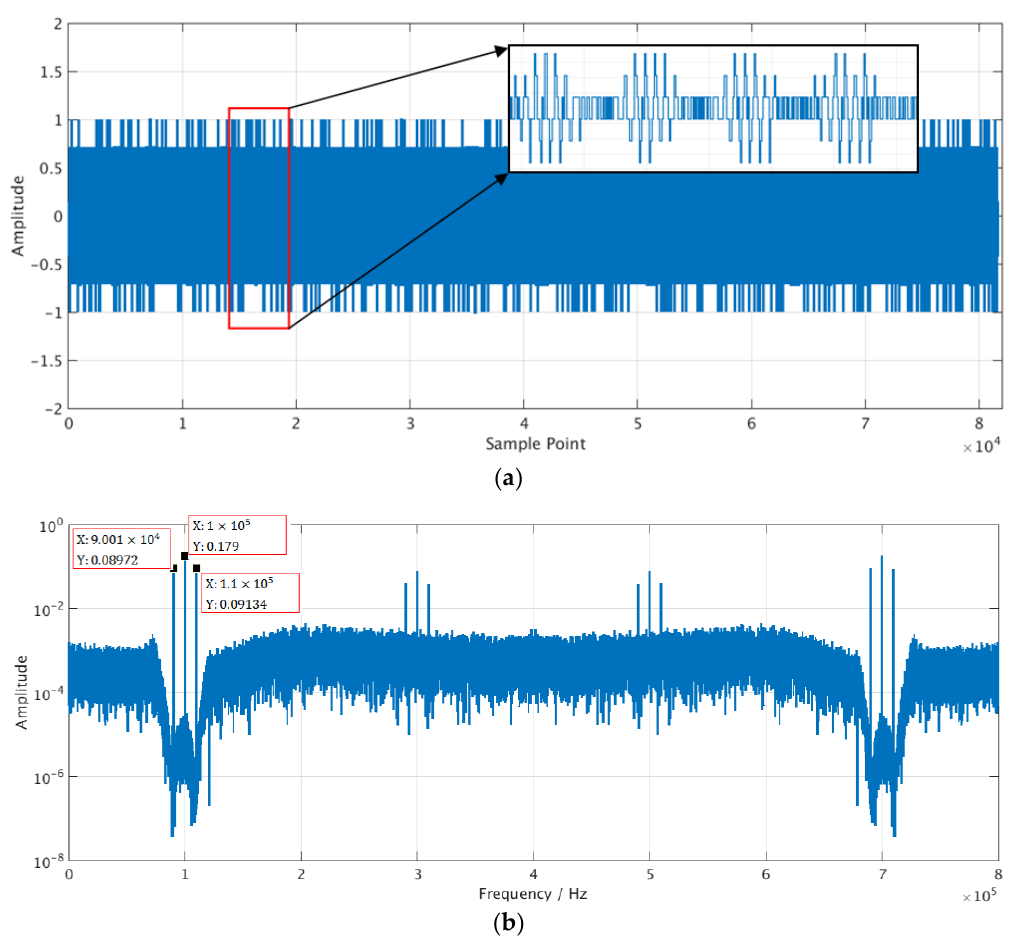
Figure 4. Simulation data of analog readout system. ( a ) Time-domain waveform of analog circuit output signal; ( b ) amplitude spectrum of the signal.